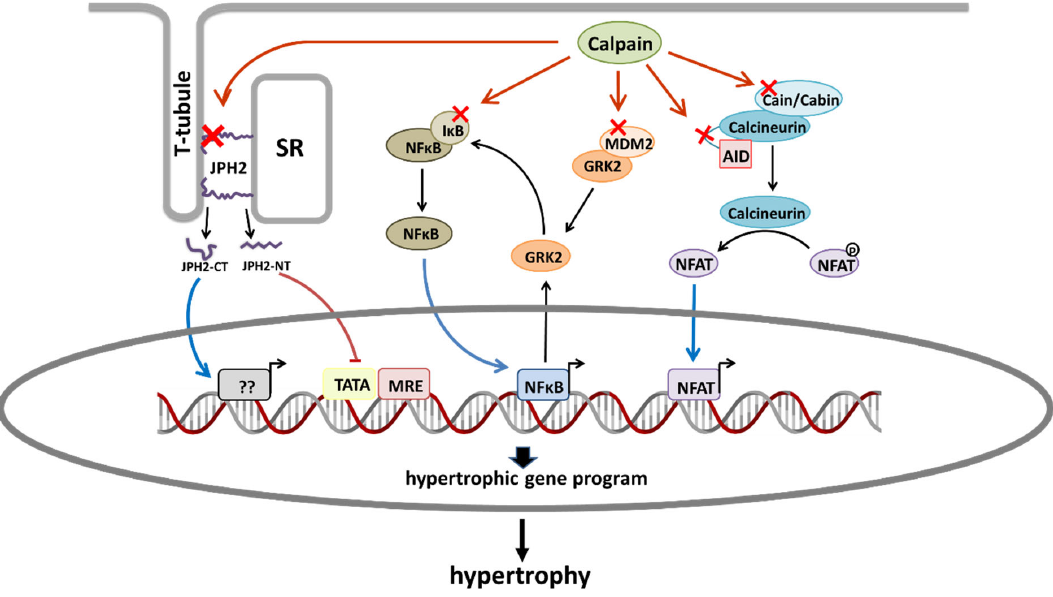
Figure 1. Schematic diagram showing the main proposed mechanisms by which calpains promote cardiac hypertrophy. Red crosses indicate calpain substrates that are involved in hypertrophic sig- naling pathways. From left to right: Calpain-2-dependent proteolysis of JPH2 generates a JPH2-CT fragment that translocates to the nucleus and favors hypertrophy. Calpain-1-dependent proteolysis of JPH2 produces a JPH2-NT fragment that acts as a stress-adaptive transcription regulator preventing hypertrophy. Calpain-dependent degradation of IkB α activates NF κ B. Calpain activity promotes the upregulation of GRK2 by mechanisms affecting both its stability (degradation of MDM2) and transcription (activation of NF κ B). GRK2 overexpression phosphorylates I κ B α promoting its proteo- somal degradation and the subsequent activation of NF κ B. Proteolysis of cain/cabin or calcineurin AID induces the activation of NFAT. AID, autoinhibitory domain; JPH2, junctophilin 2; JPH2-CT, junctophilin 2 C-terminal fragment; JPH2-NT; SR, sarcoplasmic